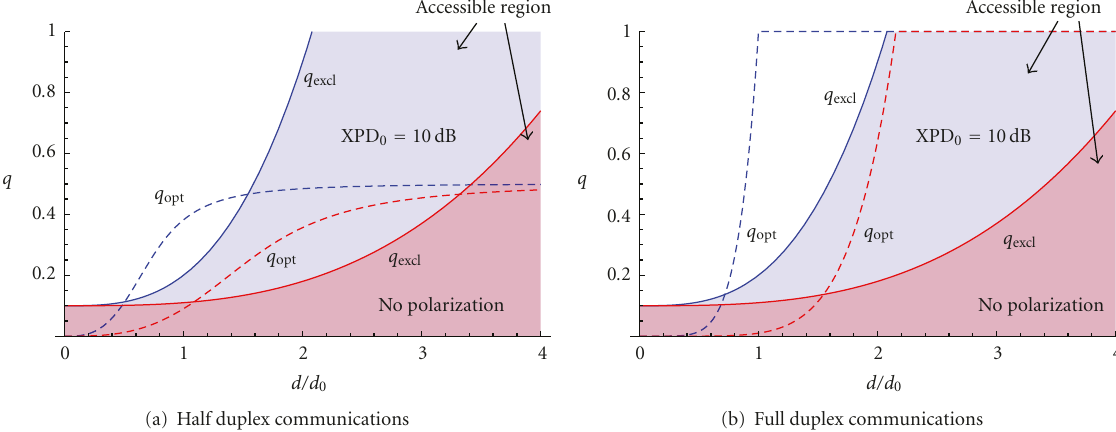
Figure 3: Accessible and optimal terminal probabilities of transmission as a function of d/d 0 and for ε = 0 . 1. In both cases, two polarization strategies are considered: (i) no polarization (drawn in red) and (ii) polarization with XPD 0 = 10dB (drawn in